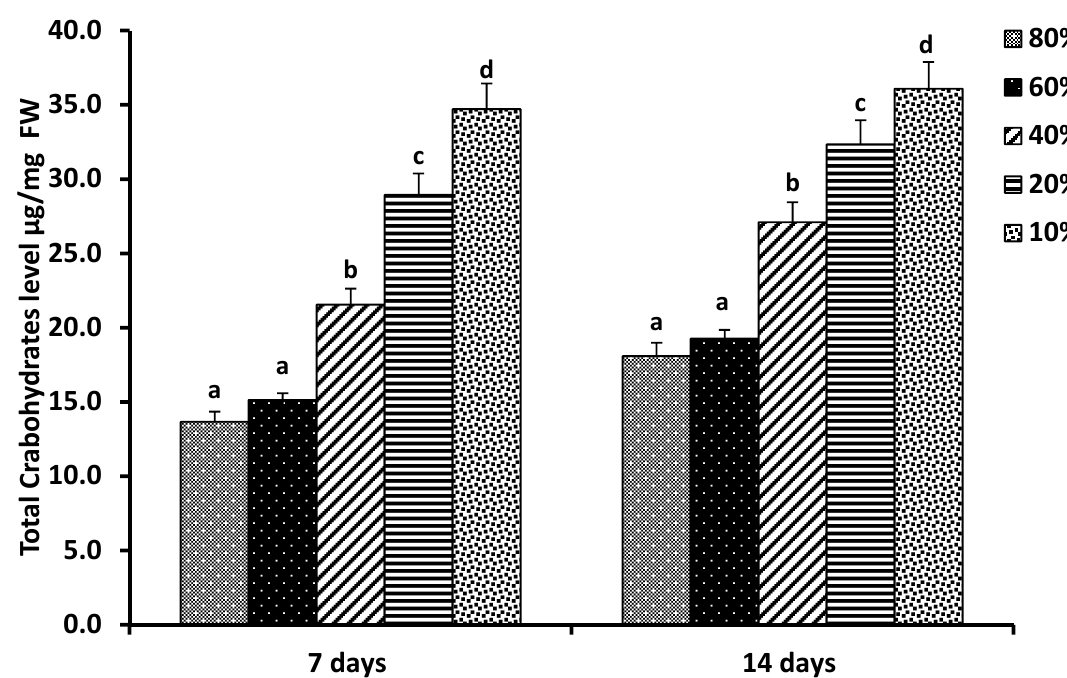
Figure 2. Total carbohydrate level of pea ( Pisum sativum L.) seedlings in response to soil water holding capacity levels: 80%, 60%, 40%, 20%, and 10% grown under continuous light at 25 °C for 7 days and 14 days, separately. Total carbohydrate level was calculated as µg/mg FW. Means (columns) with different letter scripts are significantly different ( p ≤ 0.05) by LSD.